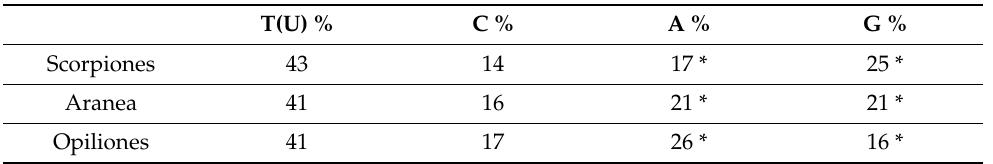
Figure 6. Percentages of nucleotides in the COI fragment in the three free living arachnid orders. T: Thymine, A: Adenine, C: Cytosine, and G: Gunaine. Table 2. Average nucleotide composition in different free-living arachnid orders. Asterisk refers to significant inter-group difference ( p =